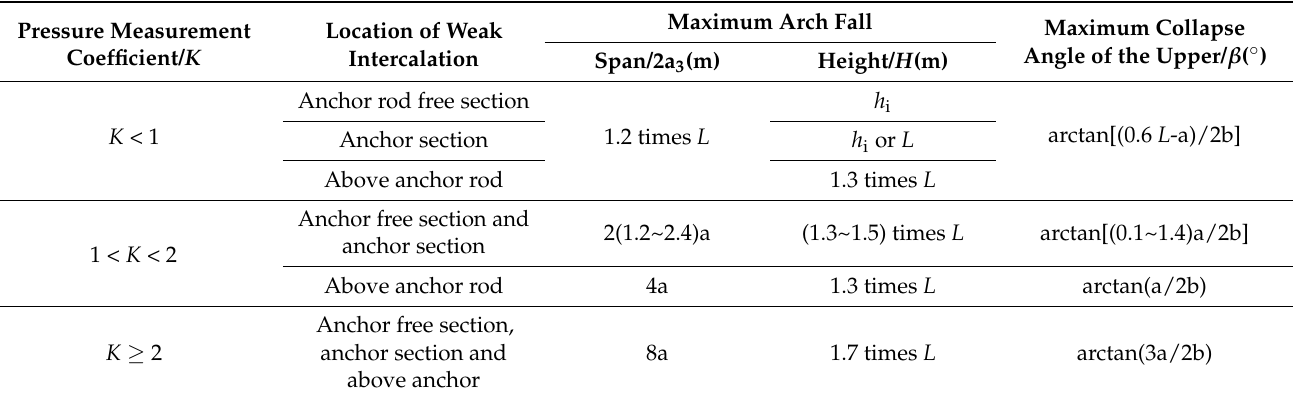
Table 5. Maximum arch falling